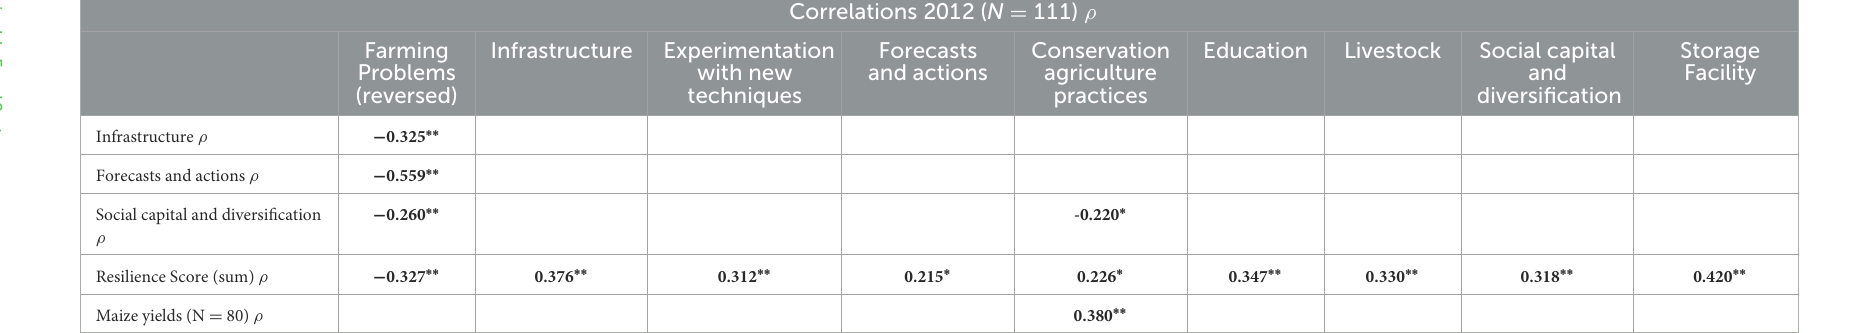
TABLE 5 Correlation matrix components of resilience 2012 (significant correlations).